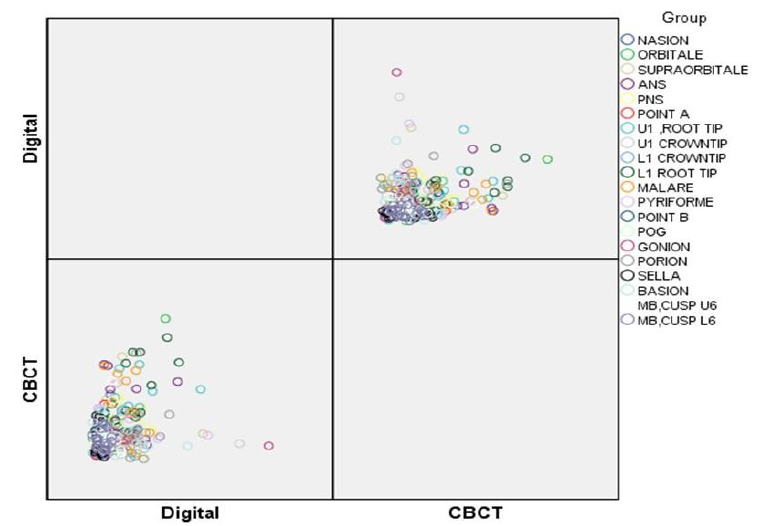
Figure 2. Inter-observer comparison of the plotting of the landmarks between the Digital and CBCT images.